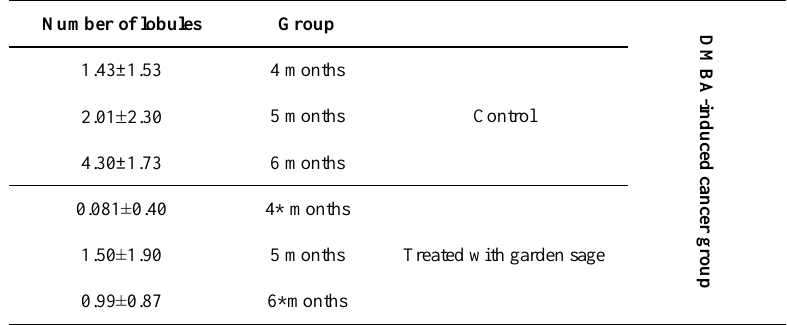
Table 2. The lobule count in the breast tissue cancer-bearing rats which received garden sage and distilled